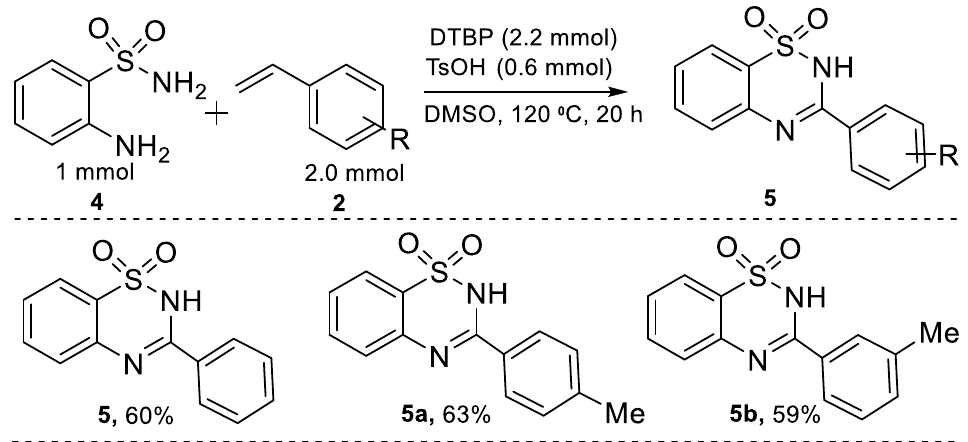
Figure 4. Synthesis of benzothiadiazine-1,1-dioxides: substrate scope a.